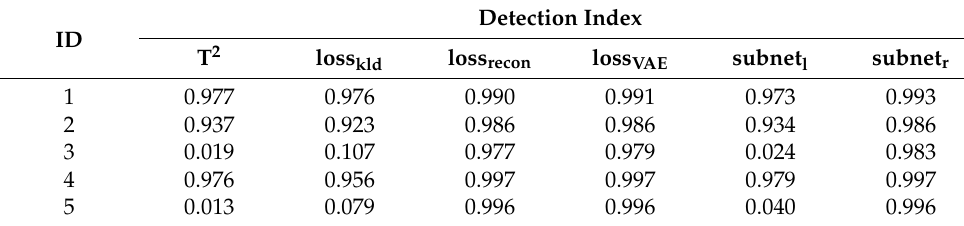
Table 6. Fault detection by